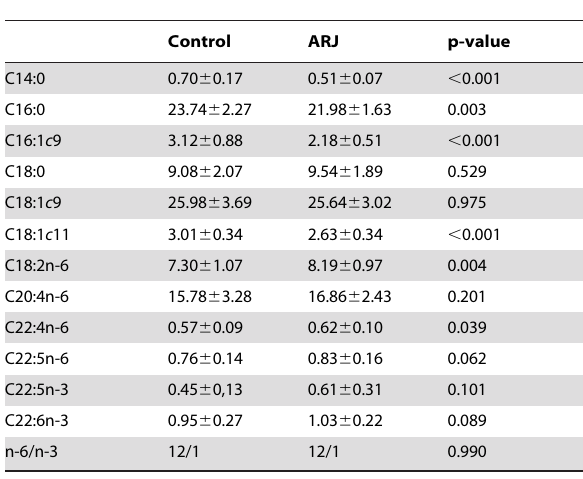
Table 3. Major fatty acids 1 [% FAME] in plasma of Fischer rats after 10 weeks of intervention with polyphenol-depleted grape-bilberry juice (control) or ARJ